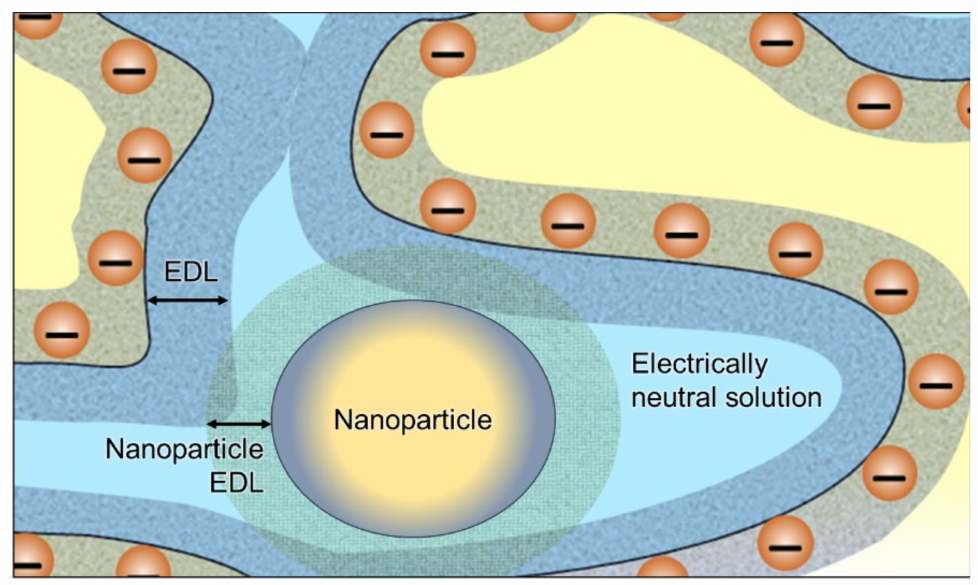
Figure 11. Schematic representation of a fragment of a mesoporous IEM containing a charged nanoparticle surrounded by an EDL. Redrawn from